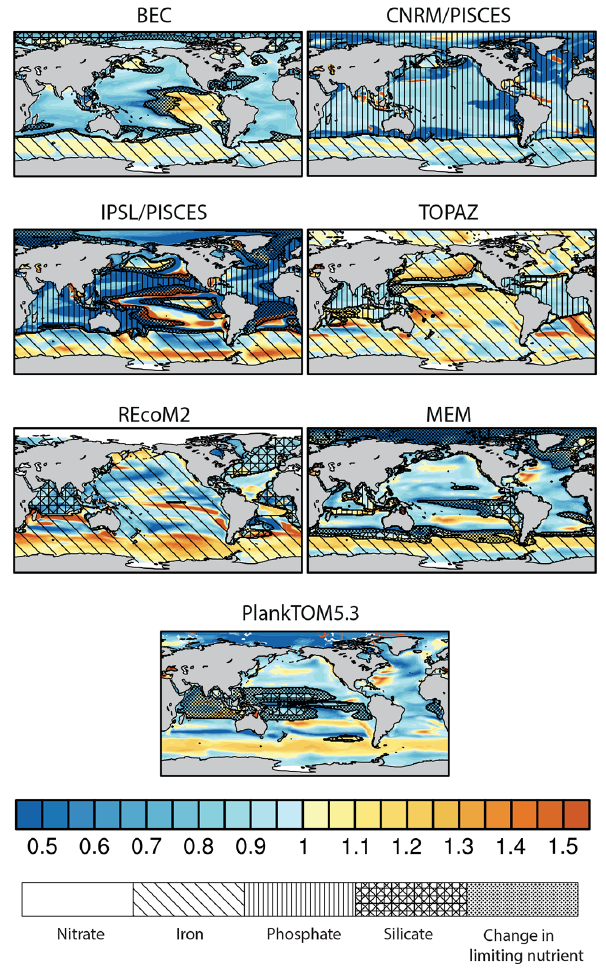
Figure 7. Changes in relative diatom nutrient limitation (calculated as the 2081–2100 average divided by the 2012–2031 average) in all models that use Liebig limitation (smallest individual nutrient limi- tation term determines total nutrient limitation). The colors indicate changes in the nutrient limitation value, with positive values indi- cating an increase in nutrient limitation factor which is equivalent to lower nutrient limitation and an increase in growth. The hatching indicates the limiting nutrient. A change in limiting nutrient during the simulation period is shown with dots. REcoM2 does not simu- late the Arctic; these missing values are shown in white.